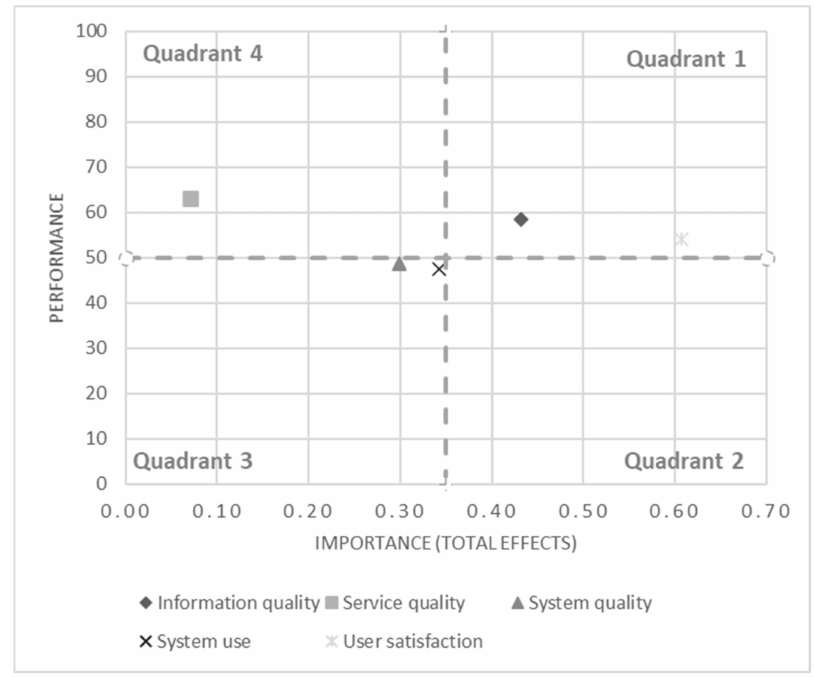
Figure 4. Importance–performance map of predecessor